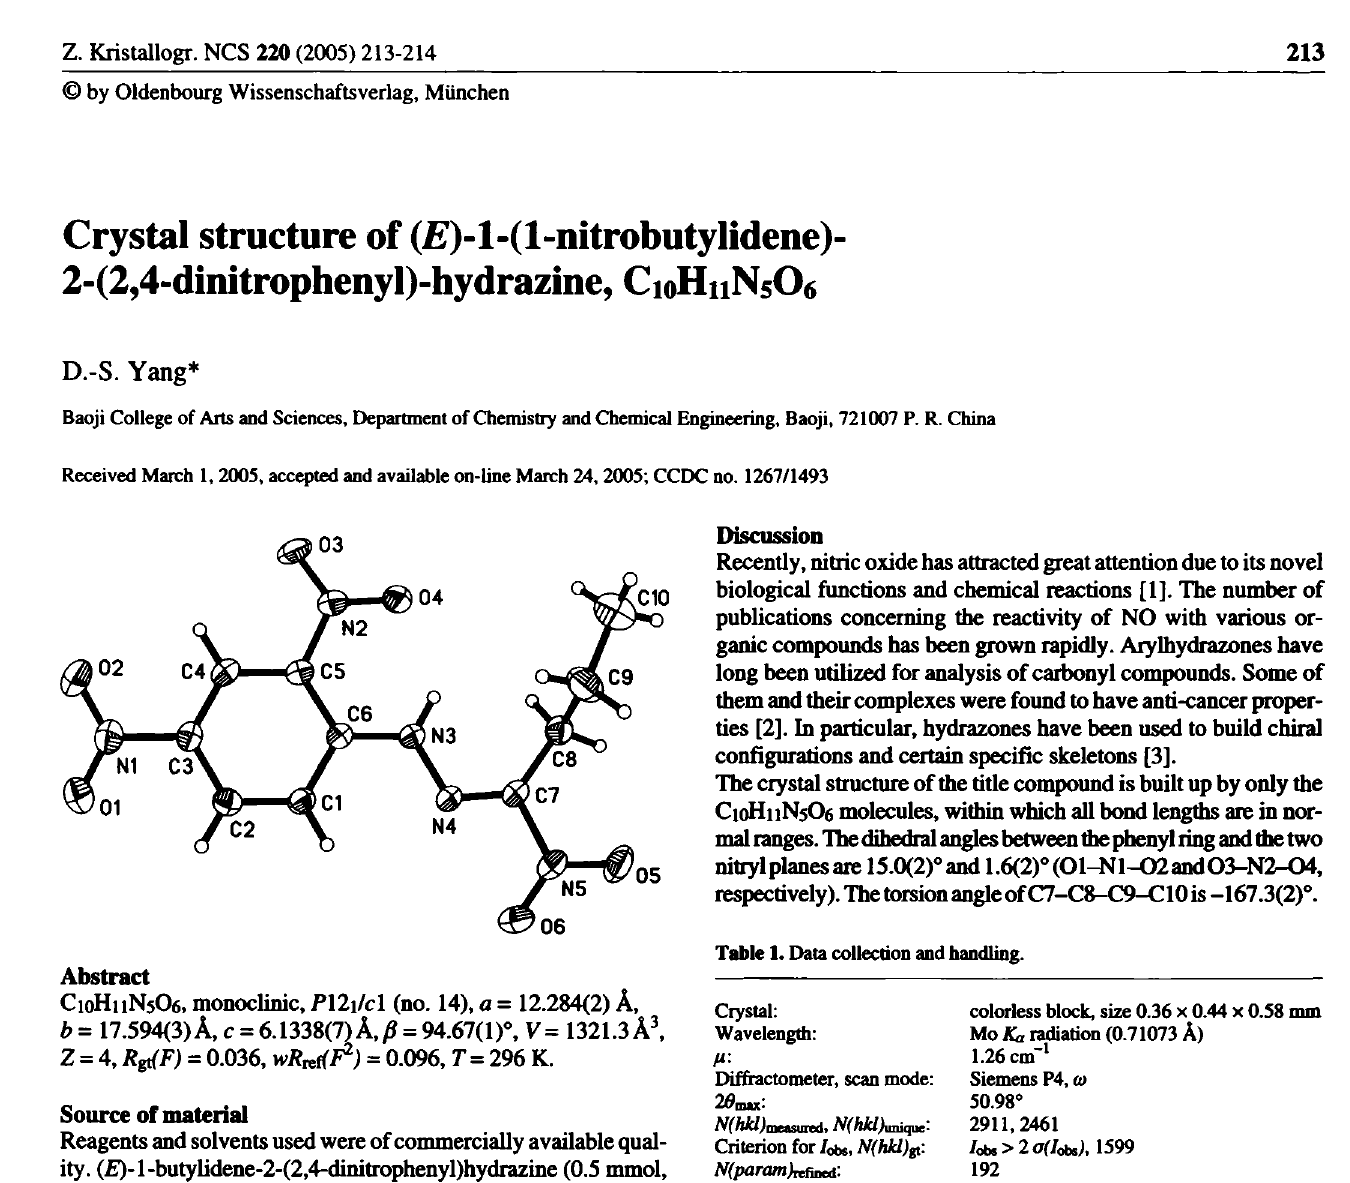
Table 2. Atomic coordinates and displacement parameters (in Ä 2